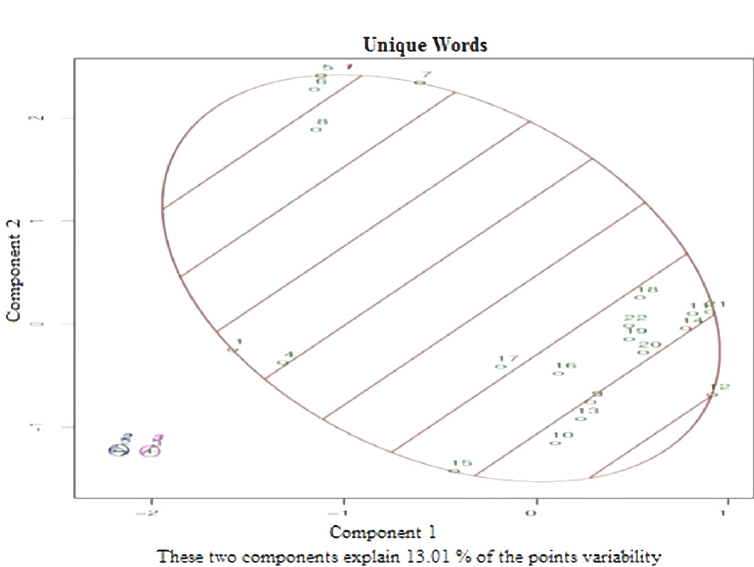
Fig. 8. K -Medoids clustering using unique words with K ¼ 3